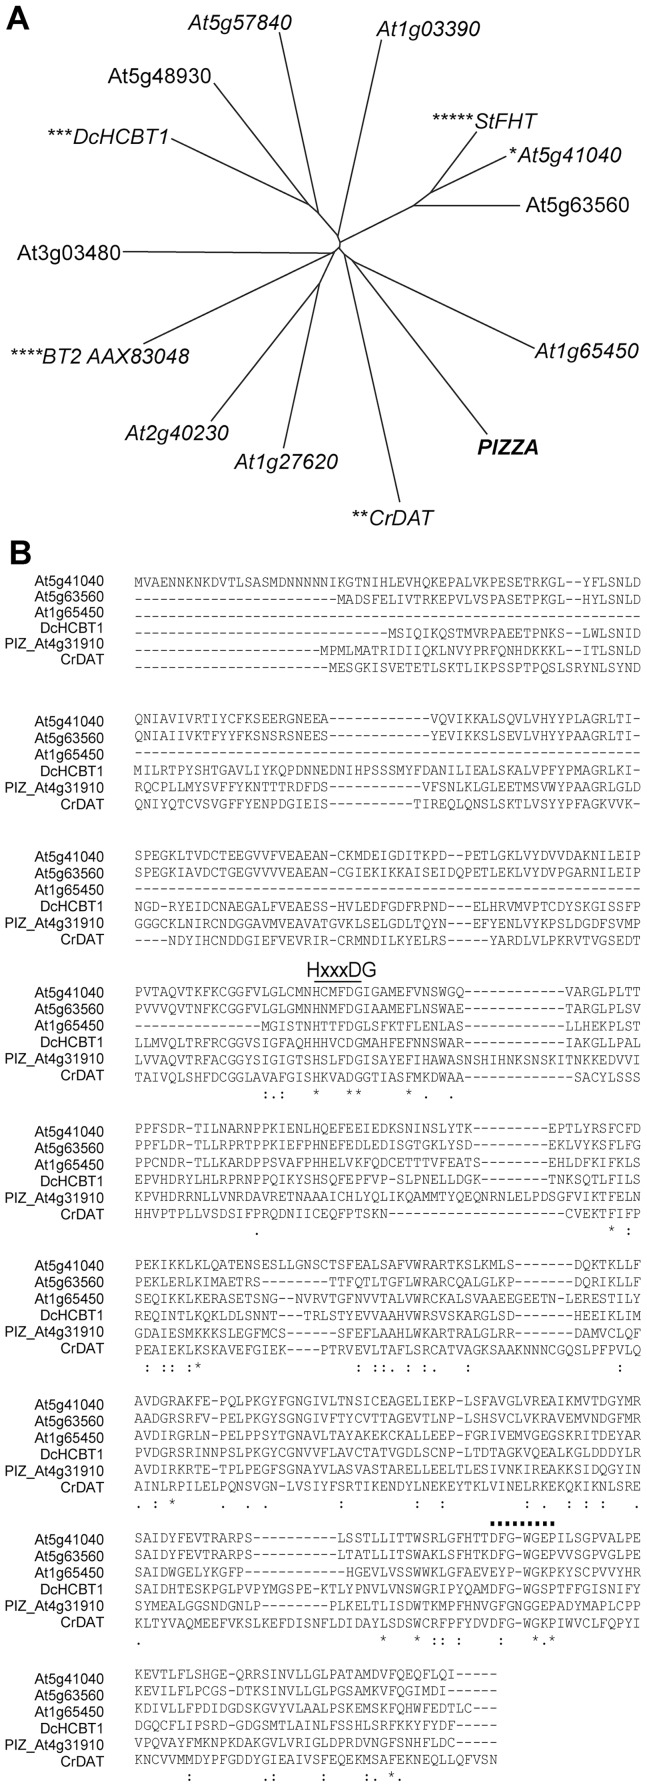
The PIZ gene structure and phylogenetic analysis.(A) The phylogenetic tree based on CLUSTALW alignment of protein sequences. *At5g41040, putative feruloyl-CoA transferase [Arabidopsis thaliana] with highest sequence similarity to PIZ. **CrDAT, deacetylvindoline 4-O-acetyltransferase [Catharanthus roseus]. ***DcHCBT1, anthranilate N-hydroxycinnamoyl/benzoyltransferase [Dianthus caryophyllus]. ****BT2 AAX83048, taxadienol acetyl transferase [Ozonium sp. BT2]. *****StFHT, BAHD feruloyl transferase [Solanum tuberosum]. (B) Amino acid sequence alignment of PIZ and its close relatives. Amino acid sequences are aligned using ClustalW. Underlined HxxxDG indicates an acyl transferase active site and dotted line marks the consensus DFGWGKP sequence conserved among these transferases.